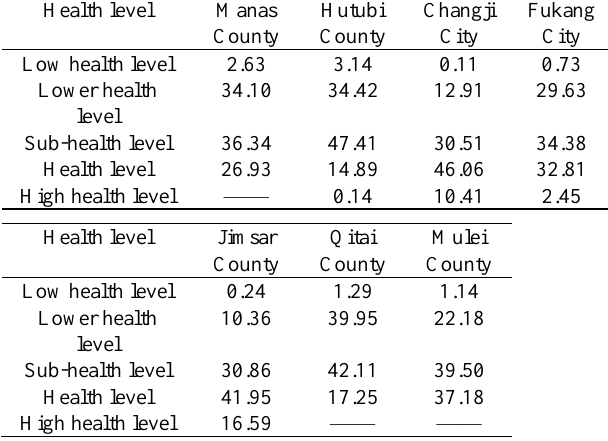
Table 3. Spatial distribution of grassland health in Changji prefecture counties and cities between 2000 and 2016 unite;%